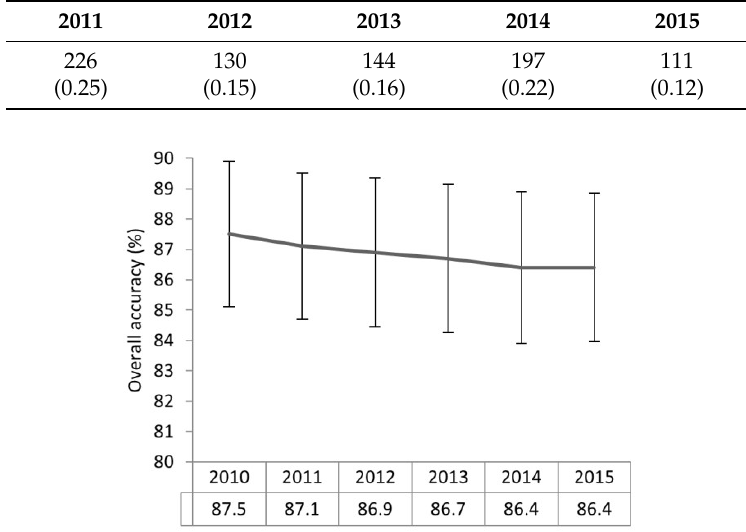
Figure 4. Estimated overall accuracy of the maps with a 95% confidence interval.